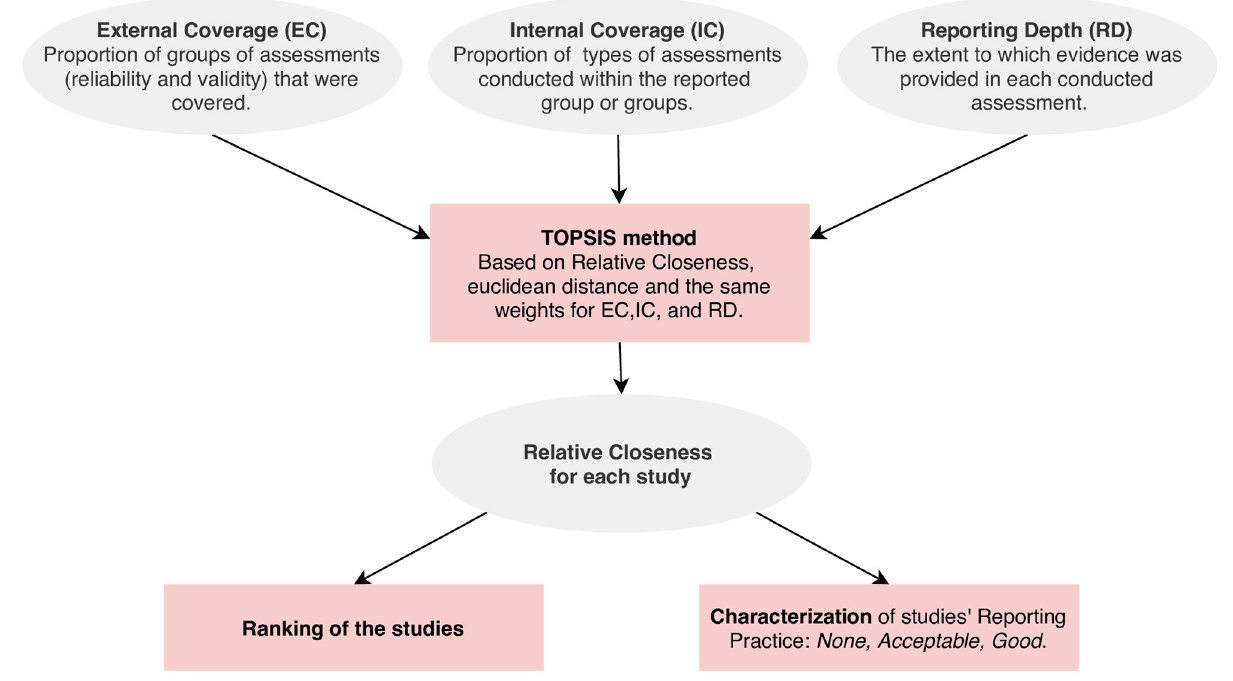
Fig 2. Process for ranking and characterizing studies’ reporting